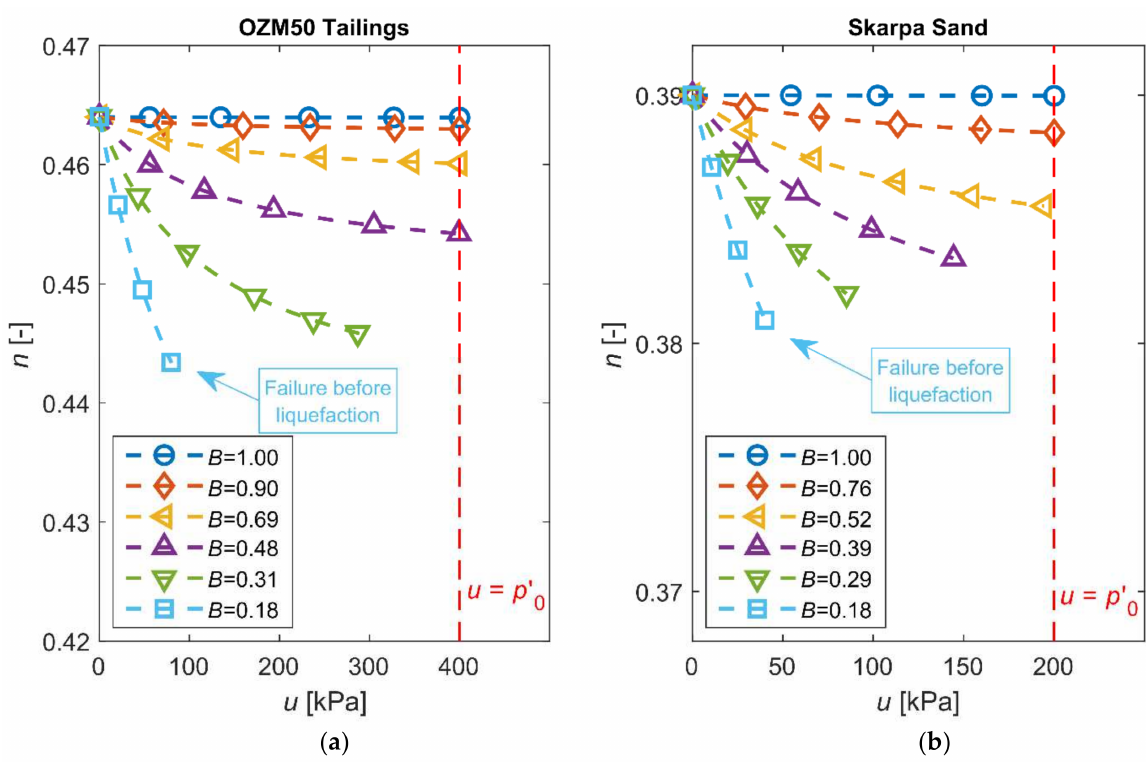
Figure 21. Model prediction of changes in porosity corresponding to simulations presented in: ( a ) Figure 18 and ( b ) Figure